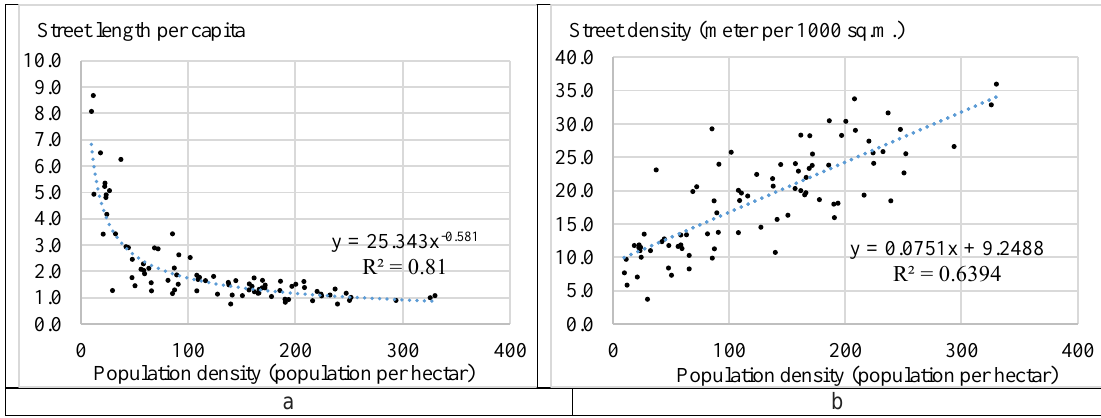
Figure 4 Correlations among street length per capita. street density and population